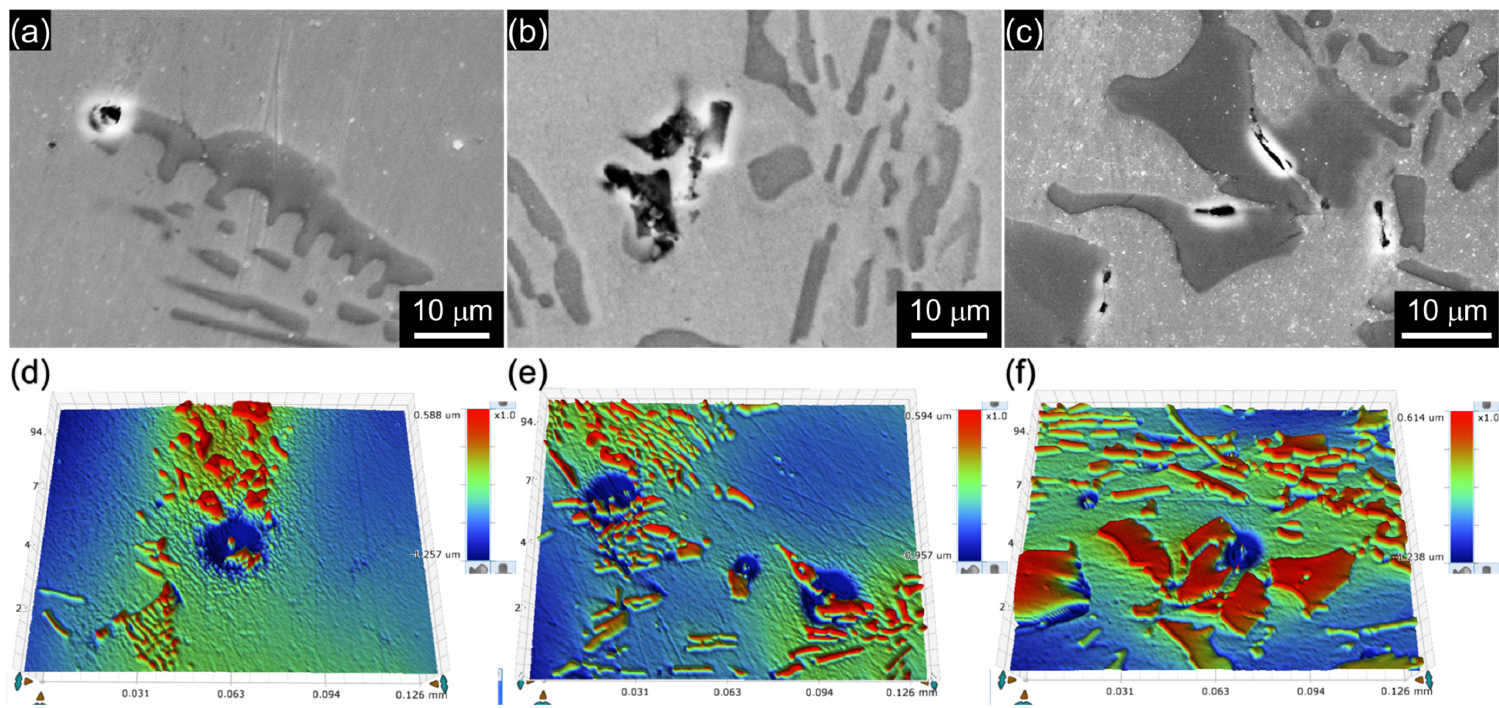
Figure 7. SEM images of the pit initiation sites of ( a ) B019, ( b ) B078, and ( c ) B176 alloys. Three-dimensional surface topographies of the pit initiation sites of ( d ) B019, ( e ) B078, and ( f ) B176 alloys.